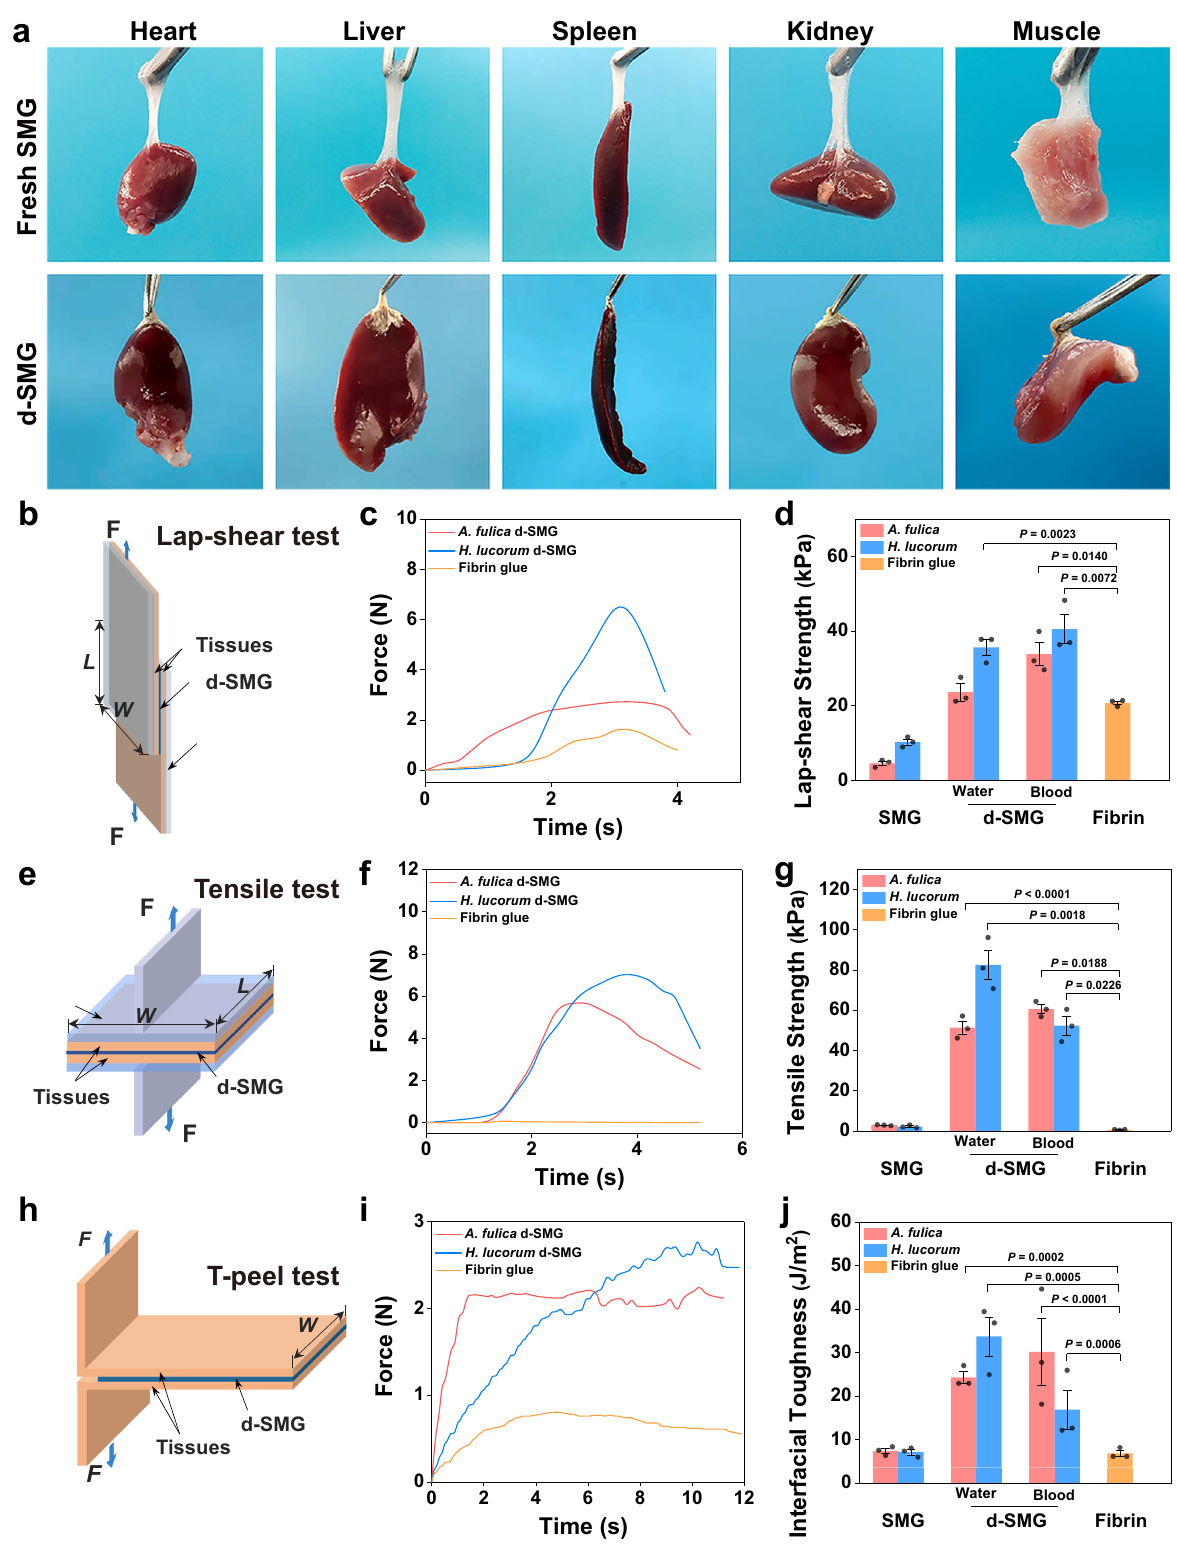
Fig. 2 | Adhesive properties of d-SMGs. a Wet adhesion properties of fresh SMG and d-SMG in rat fresh organs or tissues. b Schematic of the Lap-shear test. c Representative time-stress curves of the Lap-shear test. d Lap-shear strength of SMG and d-SMG ( n =3 biologically independent samples in each group). e Schematicof theTensileadhesiontest. f Representative time-stresscurvesofthe Tensile adhesion test. g Tensile strength of SMG and d-SMG ( n =3 biologically